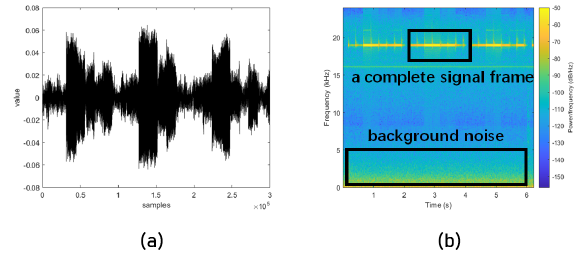
Figure 6. A segment of time-domain waveform and spectrum containing a complete frame of